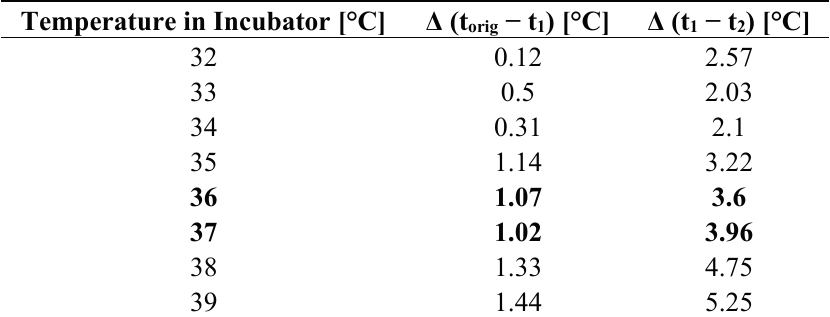
Table 4. Difference in measured temperatures inside the incubator.